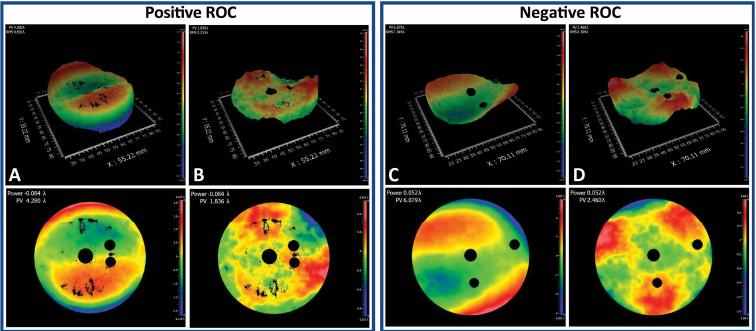
Figure 6. ( Left ) Positive ROC measurement ( A , B columns) 2D and 3D profiles with dominant aberration removed, in this instance being coma ( B column). ( Right ) Negative ROC measurement ( C , D columns) 2D and 3D profiles with dominant aberration removed, in this instance, coma and astigmatism ( D column).